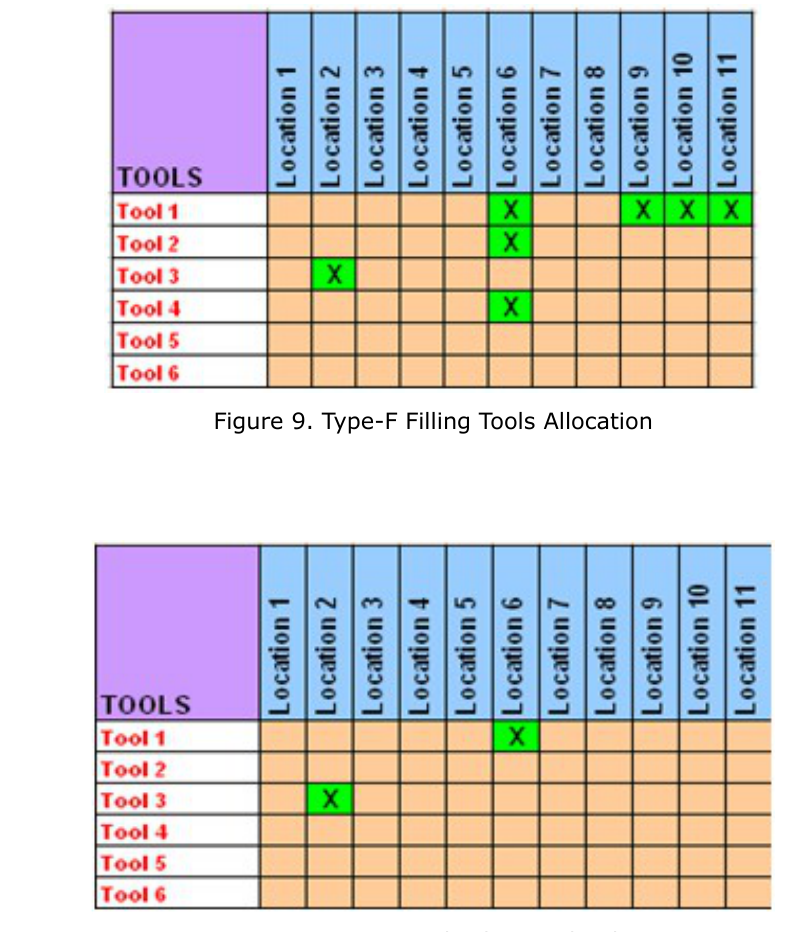
Figure 10. 2 Years Payback period